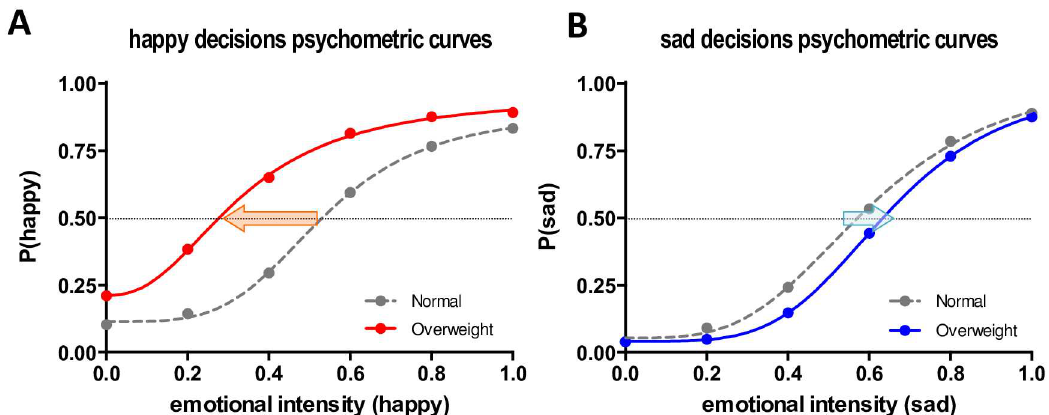
Fig 5. Psychometric curve fits. A. Happy decisions psychometric curves by body weight (Experiment 1). B. Sad decisions psychometric curves by body weight (Experiment 2). For each bodyweightcondition, psychometric curves were separately fitted by using the Naka-Rushton response function. Comparedto healthyweight faces (gray dashed line), a leftward-shift of the psychometric curve of overweight faces (red line) in the neutral-happy judgment task and a rightward-shift of the psychometric curve of sad faces (blue line) in the neutral-sadjudgment task were observed. A dotted horizontalline representsthe 50% probabilityof a happy or sad decision.